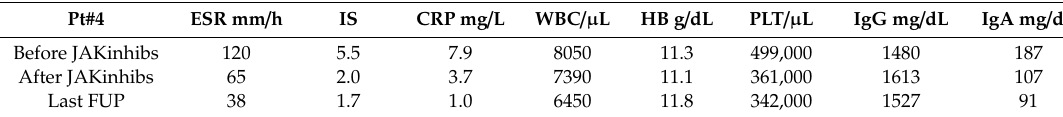
Table A4. Patient #4 laboratory